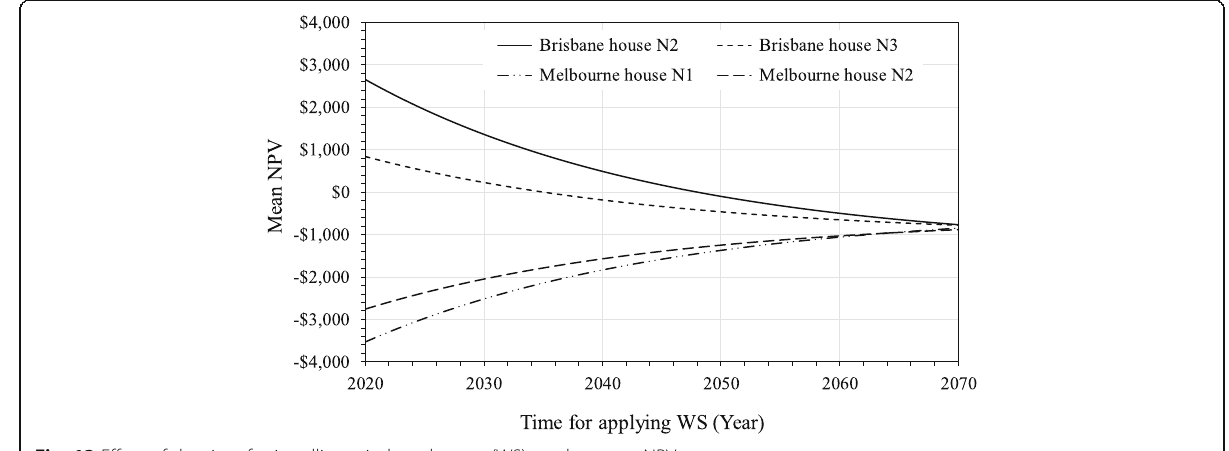
Fig. 13 Effect of the time for installing window shutters (WS) on the mean NPV